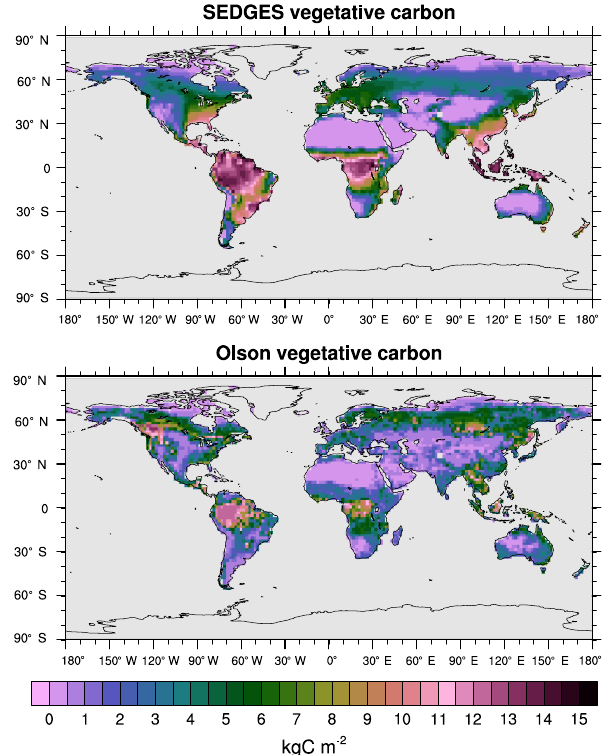
Figure 10. Linear regression trend in annual GPP for SEDGES and the CARBONES reference dataset for 1990–2009.